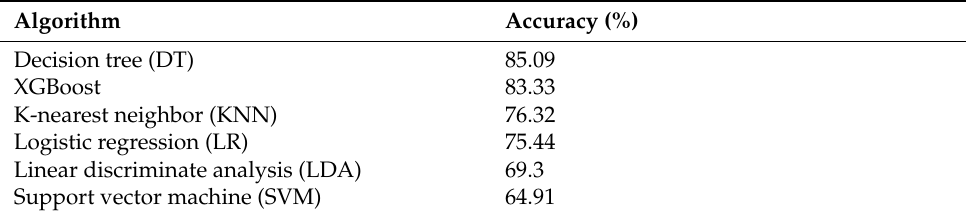
Table 7. Accuracy of